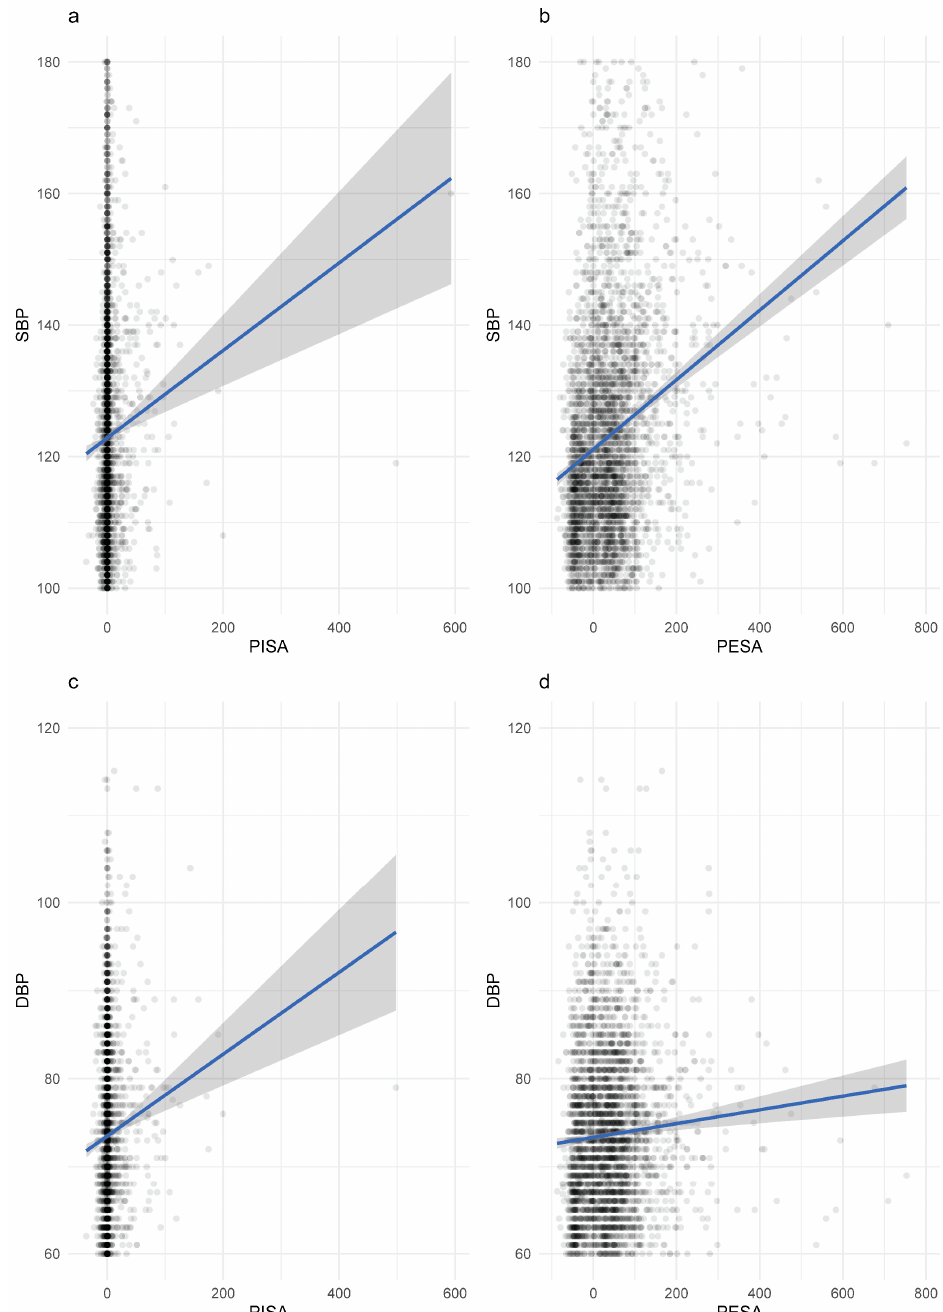
Figure 1. Scatterplots displaying the correlation between PISA with SBP ( a ) and DBP ( c ), and PESA with SBP ( b ) and DBP ( d ).